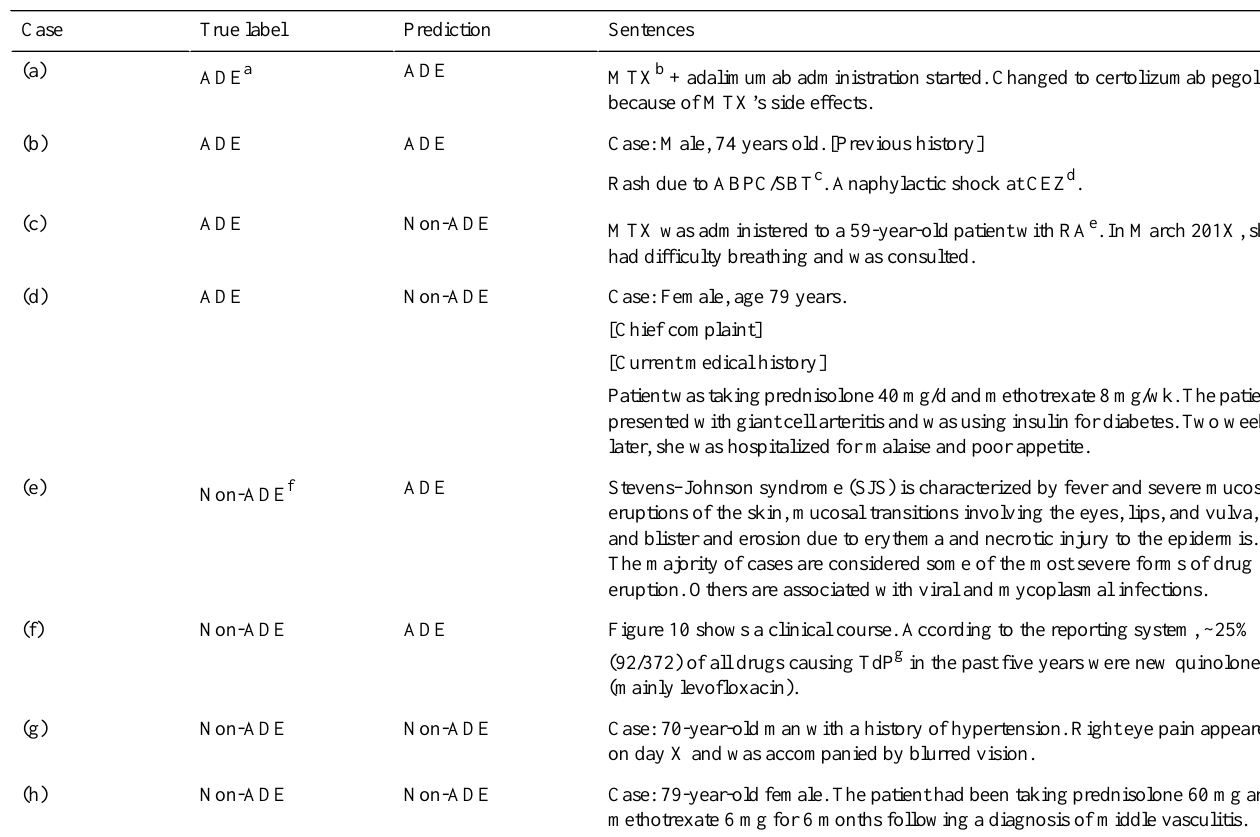
Table 5. Examples of classification results. SentencesPredictionTrue